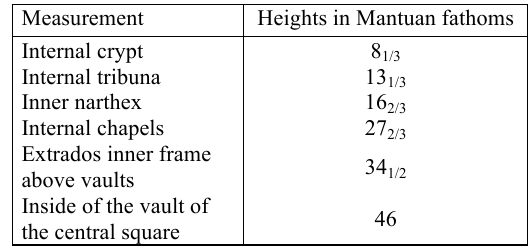
Table 4. Heights measurement in San Sebastiano